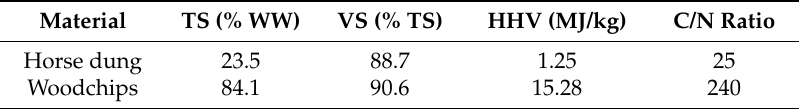
Table 1. Main characteristics for manure and wood chips bedding. WW: wet weight; TS: total solids; VS: volatile solids, HHV: high heating value; and C/N: carbon to